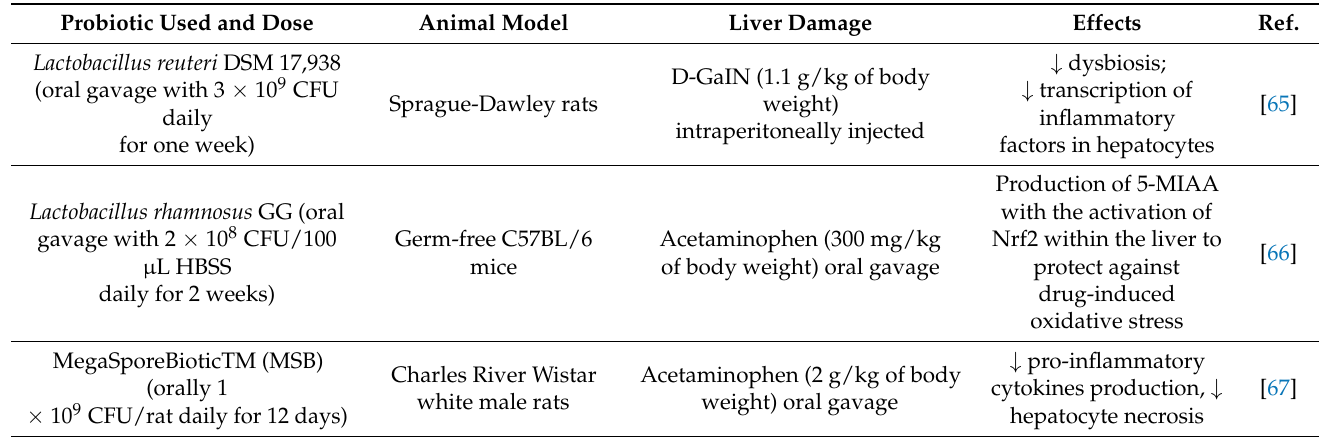
Table 2. Preclinical use of probiotics in ALF